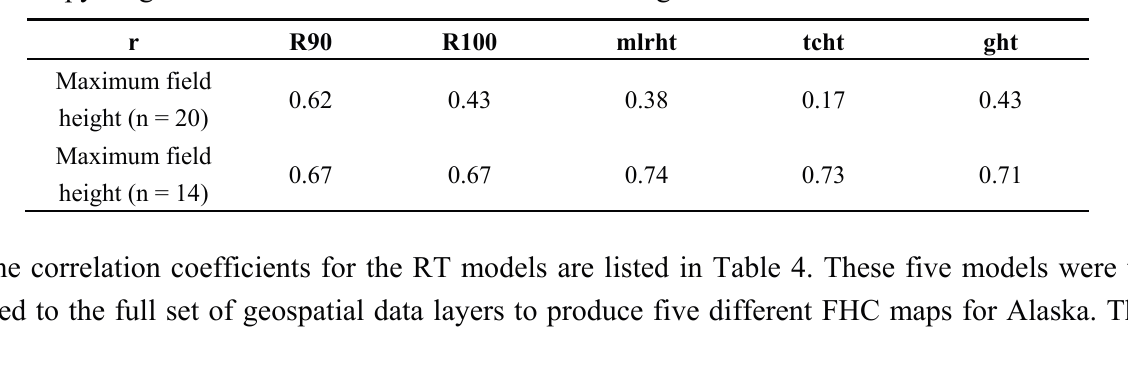
Table 3. Pearson’s correlation coefficients between field-observed canopy height and canopy height calculated from GLAS waveforms using different